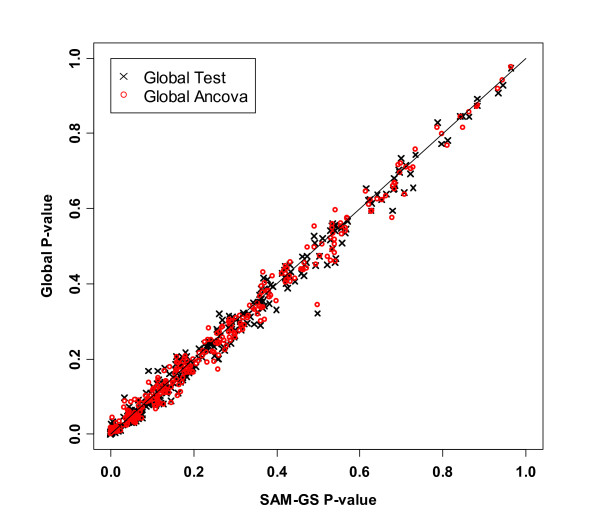
P-values of 308 gene sets in the p53 data analysis: p-values of Global Test and ANCOVA Global Test after standardization vs. SAM-GS p-values before the standardization. The line indicates equal p-values between SAM-GS and Global Tests.